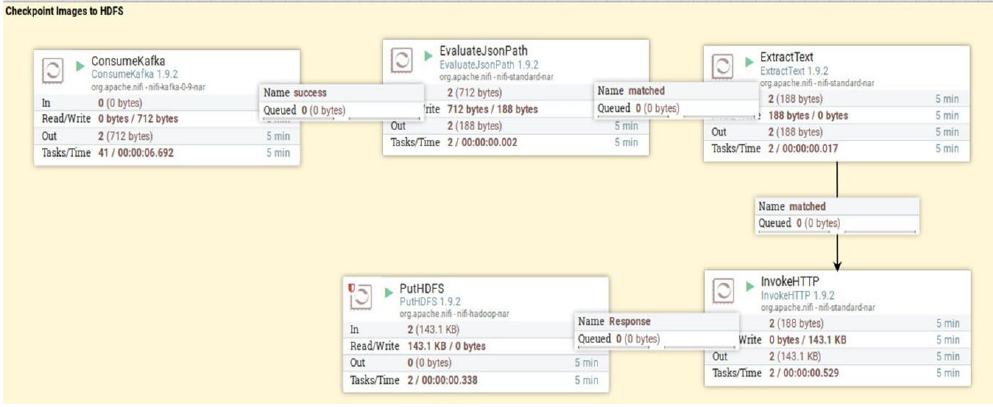
Figure 9. Data ingestion of MOBDA: Consumption of checkpoint images from Kafka to storage.